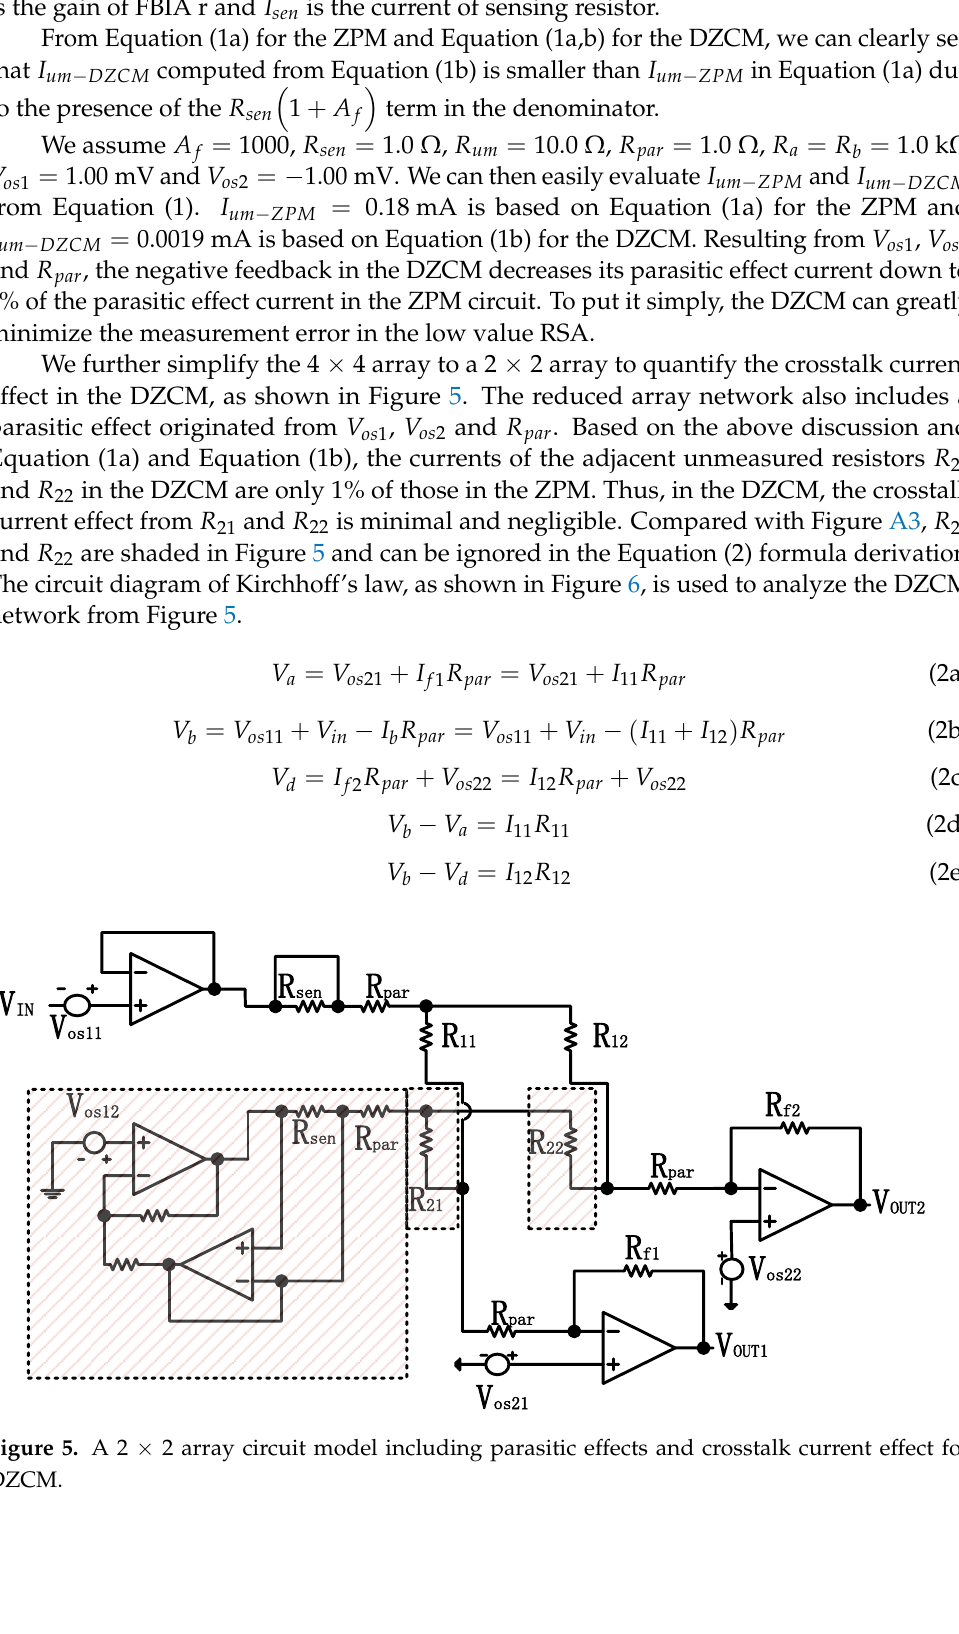
Figure 6. DZCM array network extracted and analyzed with Kirchhoff ’s law. 𝑉 𝑎 = 𝑉 𝑜𝑠21 + 𝐼 𝑓1 𝑅 𝑝𝑎𝑟 = 𝑉 𝑜𝑠21 + 𝐼 11 𝑅 𝑝𝑎𝑟